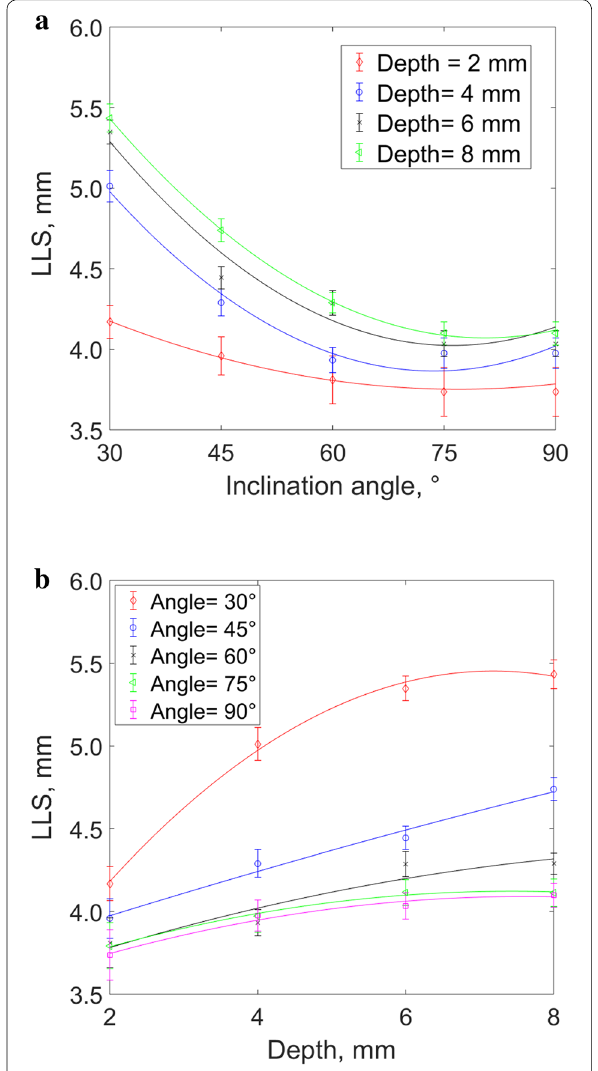
Figure 5 Correlation of LLS with ( a ) inclination angle, at different depths and ( b ) depth, at different inclination angle